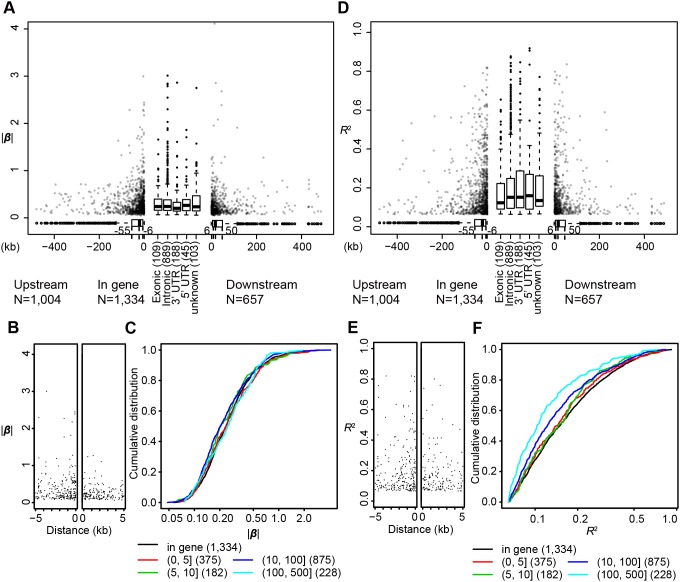
Relationships between effects of cis-eQTLs and distance from genes.|β| values (A) and R
2 values (D) of cis-eQTLs that affect mRNA transcripts are plotted against distances from the respective target genes by scatter (non-transcribed regions) and by box-and-whisker plots (transcribed regions). eQTLs in transcribed regions are shown for each gene-structure-based category. The number following each category name represents the number of cis-eQTLs classified into that category. Negative distance values indicate that the eQTL is upstream of the target gene, and positive values indicate that it is downstream, regarding transcriptional directions. Distributions of distances are represented by box-and-whisker plots below the scatters. Magnified view for <5 kb of genes is shown for |β| (B) and R
2 (E). Cumulative distribution of |β| (C) and R
2 (F) of eQTLs are shown for each division of eQTLs; each division represent a defined distance (kb) from the respective target gene. The number in the parentheses following each distance range in the legend is the number of cis-eQTLs identified in that range. The X-axis is a log scale. One eQTL located within a gene (C16orf55) that was assigned function of “downstream” is shown as “unknown”; therefore, the number of “In gene” eQTLs shown in (A) and (D) is the sum of the numbers of Exonic, Splicing, Intronic, 5′ UTR, 3′ UTR, and N.A. in Table 2 plus 1.